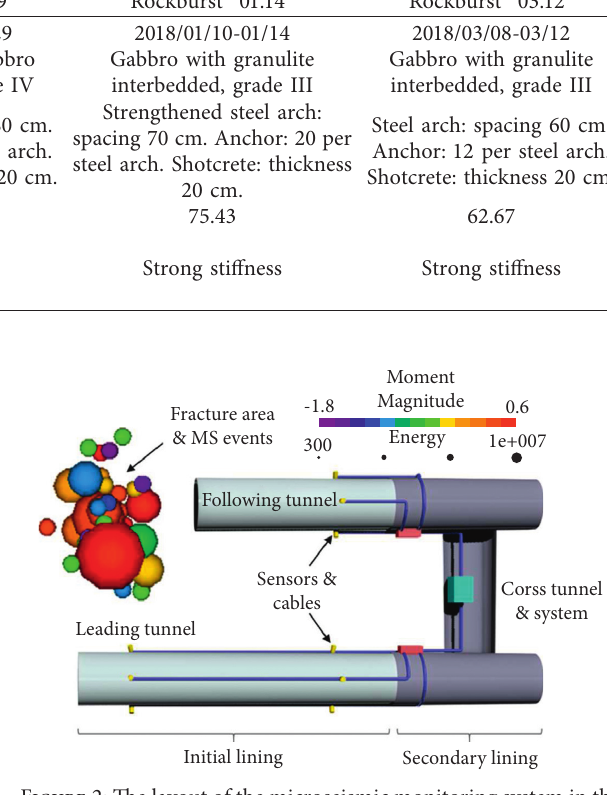
Figure 2: The layout of the microseismic monitoring system in the Micangshan